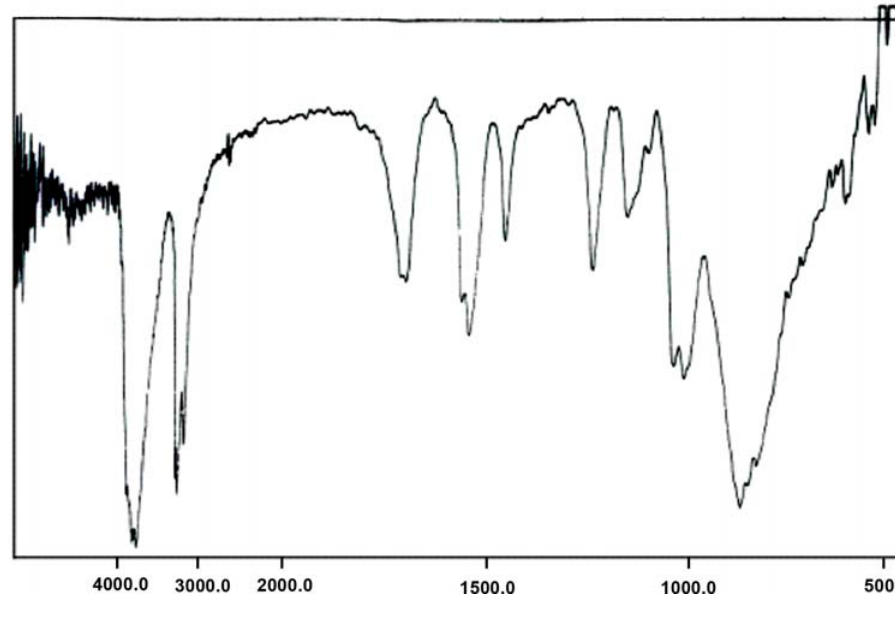
Figure 2. IR spectrum of compound B.